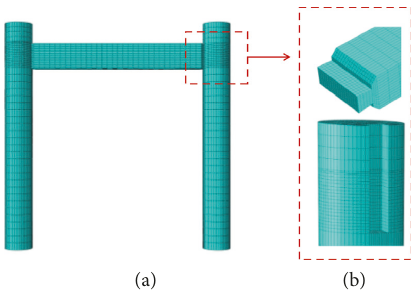
Figure 9: Meshes of (a) column frame and (b) mortise and tenon joint.